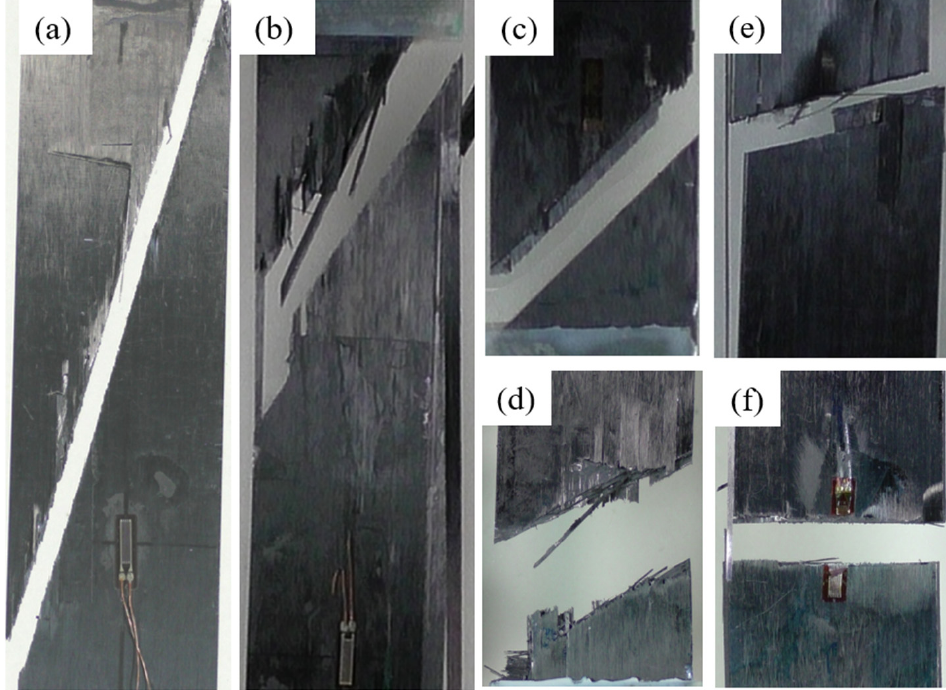
Figure 4. Failure images of the [0/ θ ] 2s laminate, ( a ) [0/15] 2s , ( b ) [0/30] 2s . ( c ) [0/45] 2s , ( d ) [0/60] 2s , ( e ) [0/75] 2s , and ( f ) [0/90] 2s .